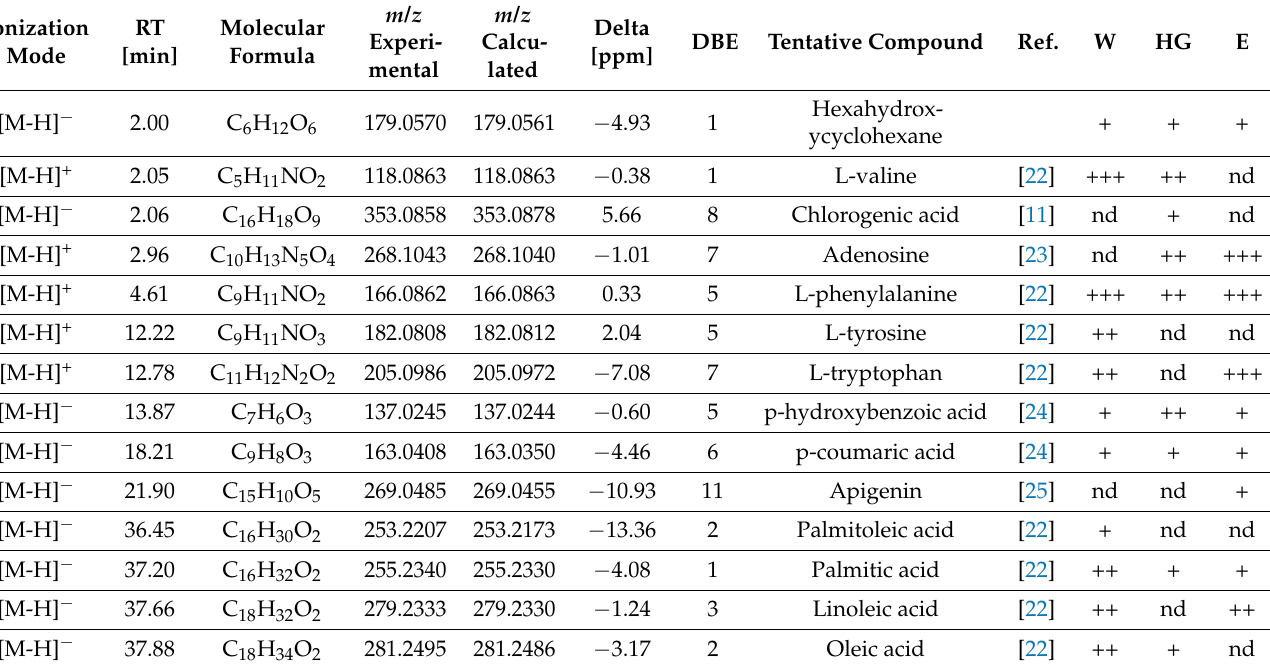
Table 2. The tentatively identified compounds in C. maxima ‘Halloween’ peel extracts.